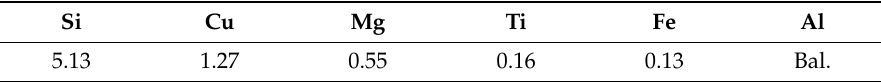
Table 1. Chemical composition of the Al ‐ 5Si ‐ 1Cu ‐ 0.5Mg aluminum alloy used in the experiment (mass fraction, %).